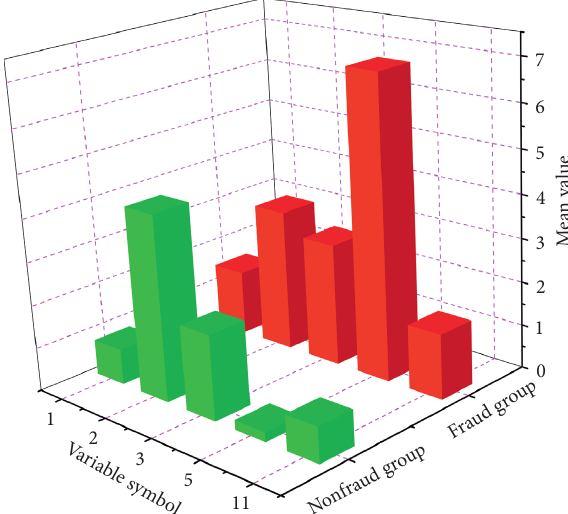
Figure 12: Mean value statistics of different groups.